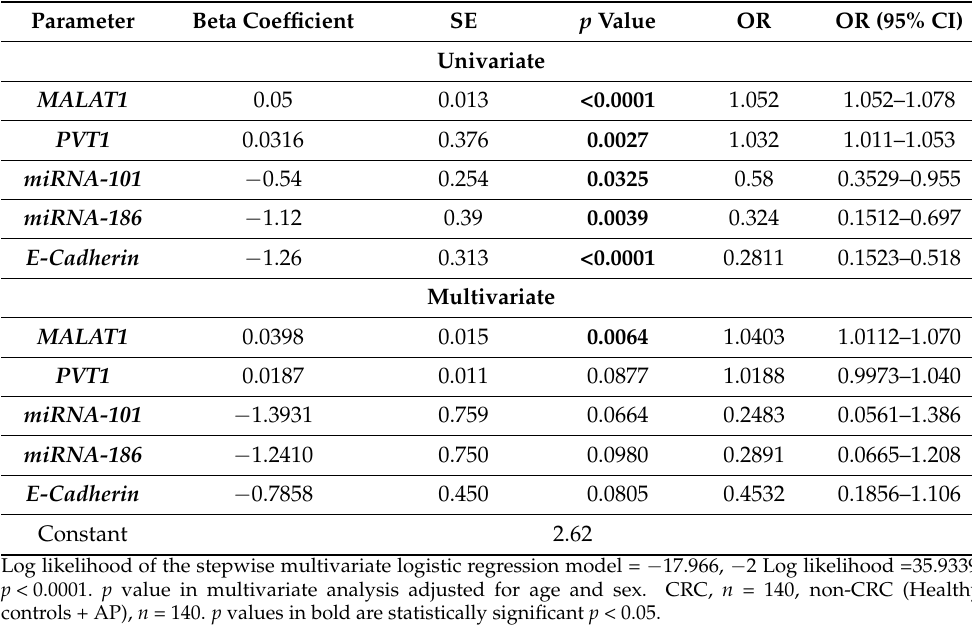
Table 6. Logistic regression analysis to predict the risk of CRC in non-CRC groups.